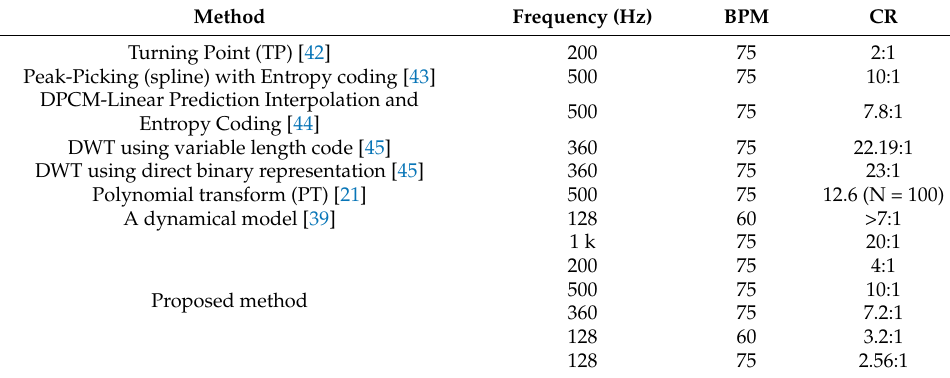
Table 4. Comparison of ECG compression